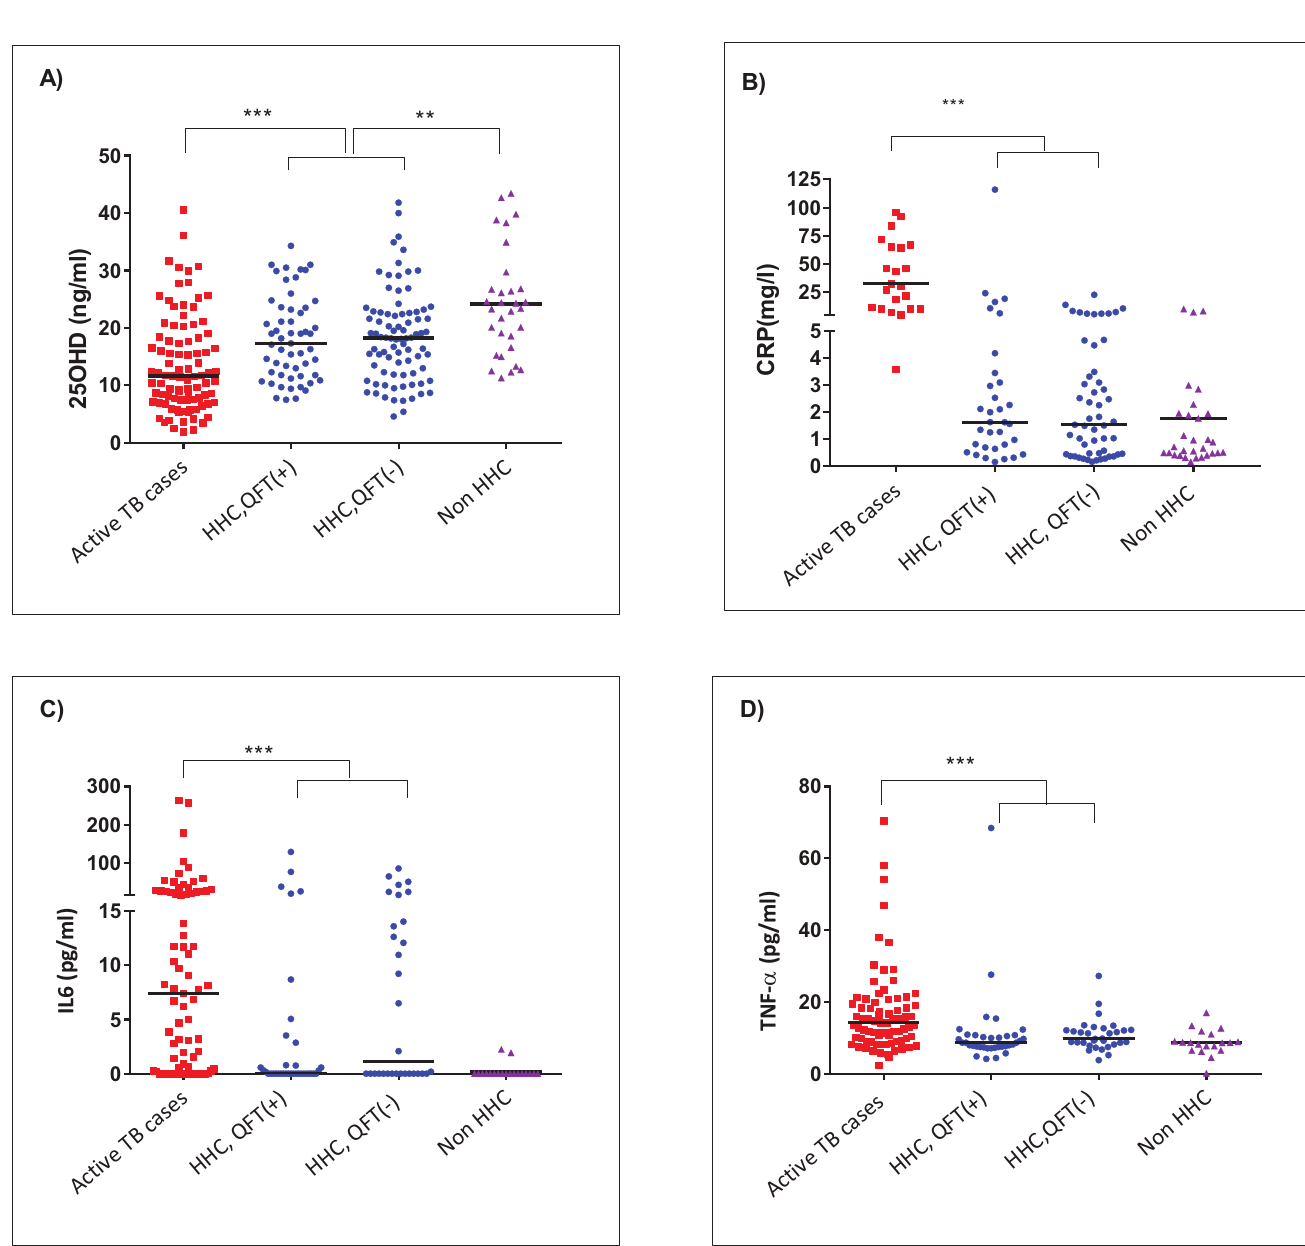
Fig 1. Plasmalevels of 25OHD and inflammatory parameters in active pulmonary TB cases, household contacts (HHC) and non-HHC subjects. A) 25OHD levels in active pulmonary TB cases (n = 92), householdcontacts (HHC) with latent TB infection(QFT(+), n = 55), HHC without latent TB infection(QFT(-), n = 84) and non-HHCsubjects (n = 31). B) Ultrasensitive C-reactiveprotein (CRP) in active pulmonary TB cases (n = 23), HHC with latent TB infection(QFT(+), n = 33), HHC without latent TB infection(QFT(-), n = 53) and non-HHC subjects (n = 31). C) Interleukin 6 (IL-6) in active pulmonary TB cases (n = 79), HHC with latent TB infection(QFT(+), n = 36), HHC without latent TB infection(QFT(-), n = 32) and non-HHC subjects (n = 19). D ) TNF- α in active pulmonary TB cases (n = 79), HHC with latent TB infection(QFT(+), n = 36), HHC without latent TB infection(QFT (-), n = 32) and non-HHCsubjects(n = 19). ( *** = p < 0.001, ** = p < 0.01, * = p < 0.05).Horizontalline representsthe median of each subject